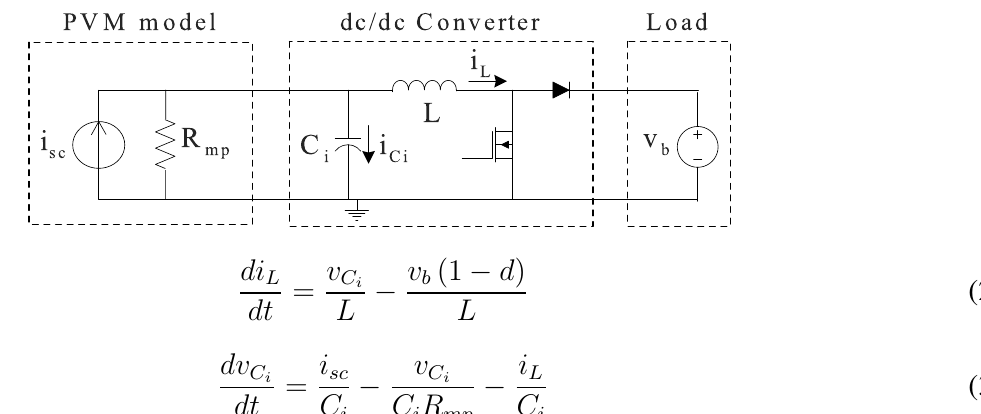
Figure 8. Loss-free PV system considering a bulk voltage